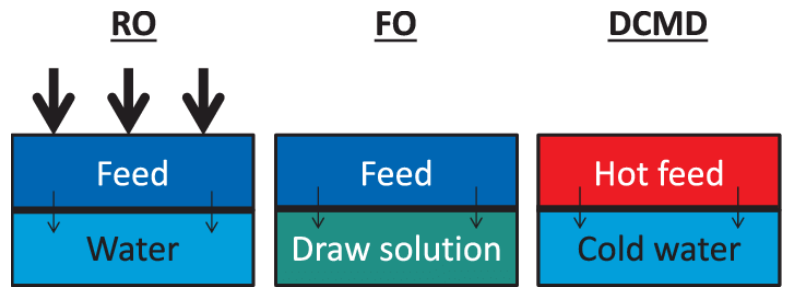
Figure 14. Working principles of reverse osmosis, forward osmosis and membrane distillation Reprinted from [185] with permission from Elsevier, 2018.